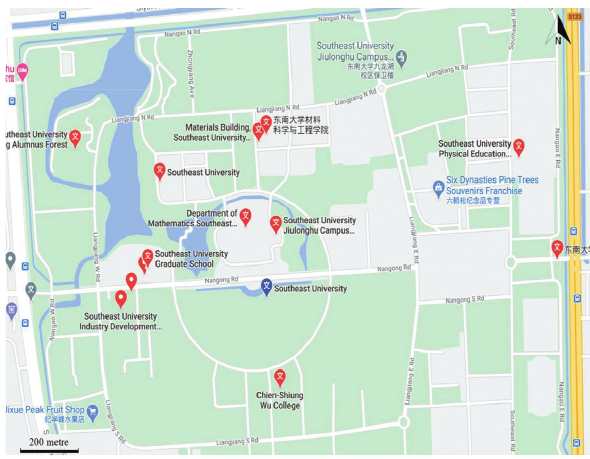
Figure 1: Southeast University Kowloon lake campus